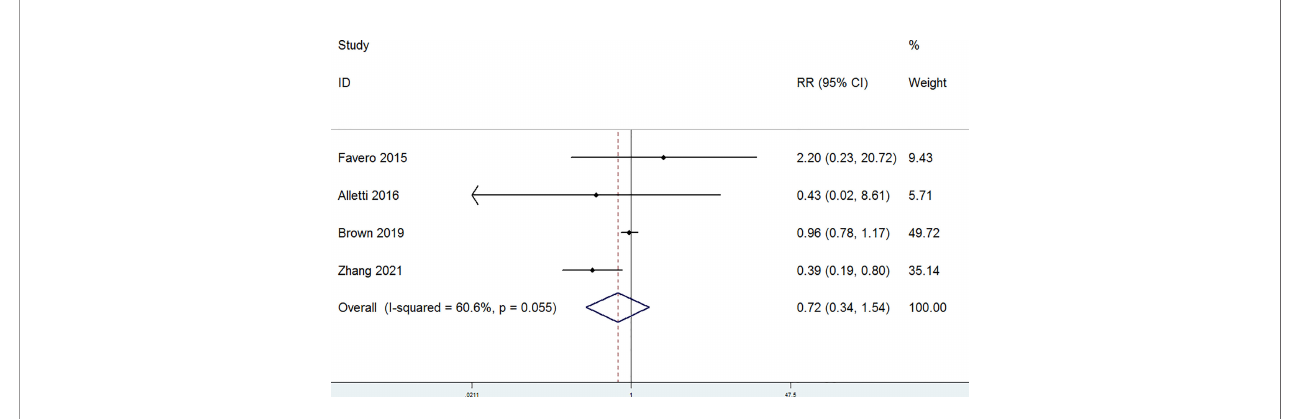
FIGURE 6 | Forest plots for postoperative complications.